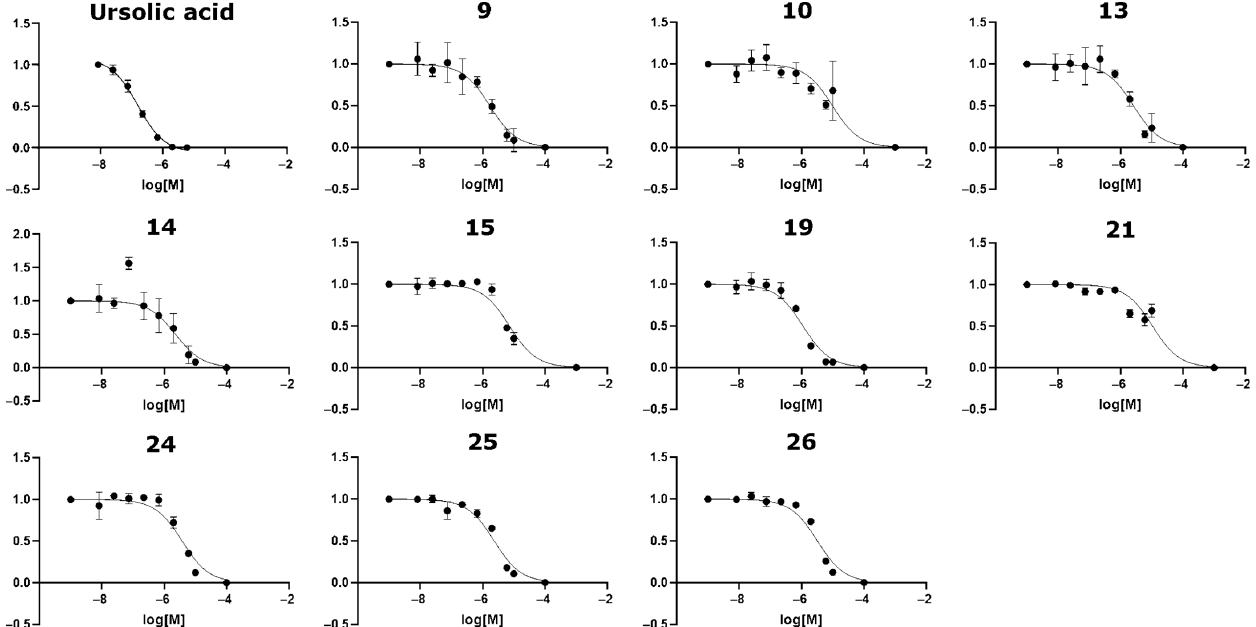
Figure 6. IC 50 plots for the ROR γ t inverse agonists tested in this study. The IC 50 plots are shown for the active compounds: 9 , 10 , 13 – 15 , 19 , 21 , 24 – 26 , and the control ursolic acid. For ursolic acid, the plot was formed by an average of three duplicate repeat measurements. A fourth duplicate measurement was omitted due to high measurement error at several ursolic acid concentrations.